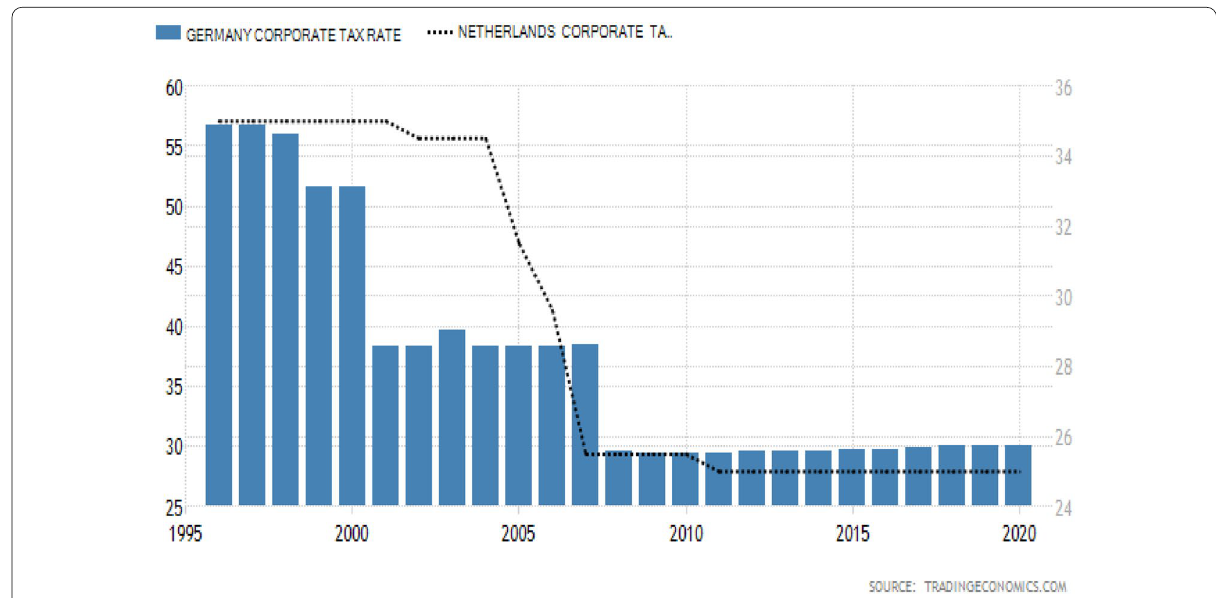
Fig. 4 The Netherlands and Germany corporate tax rate from